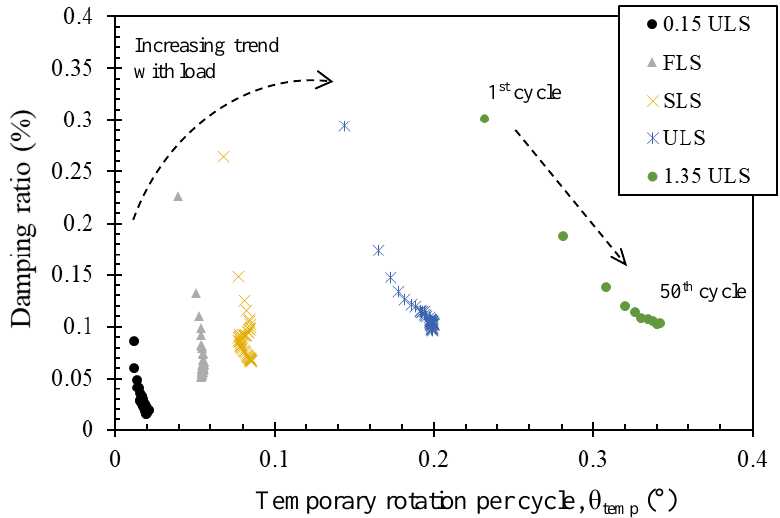
Figure 11. Damping ratio – rotation curve under different load amplitudes.